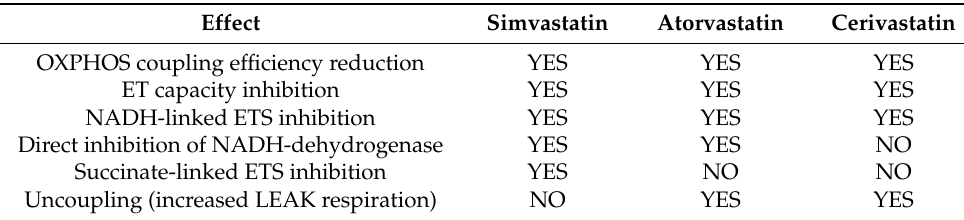
Table 1. Summary of the respiratory effects of the studied